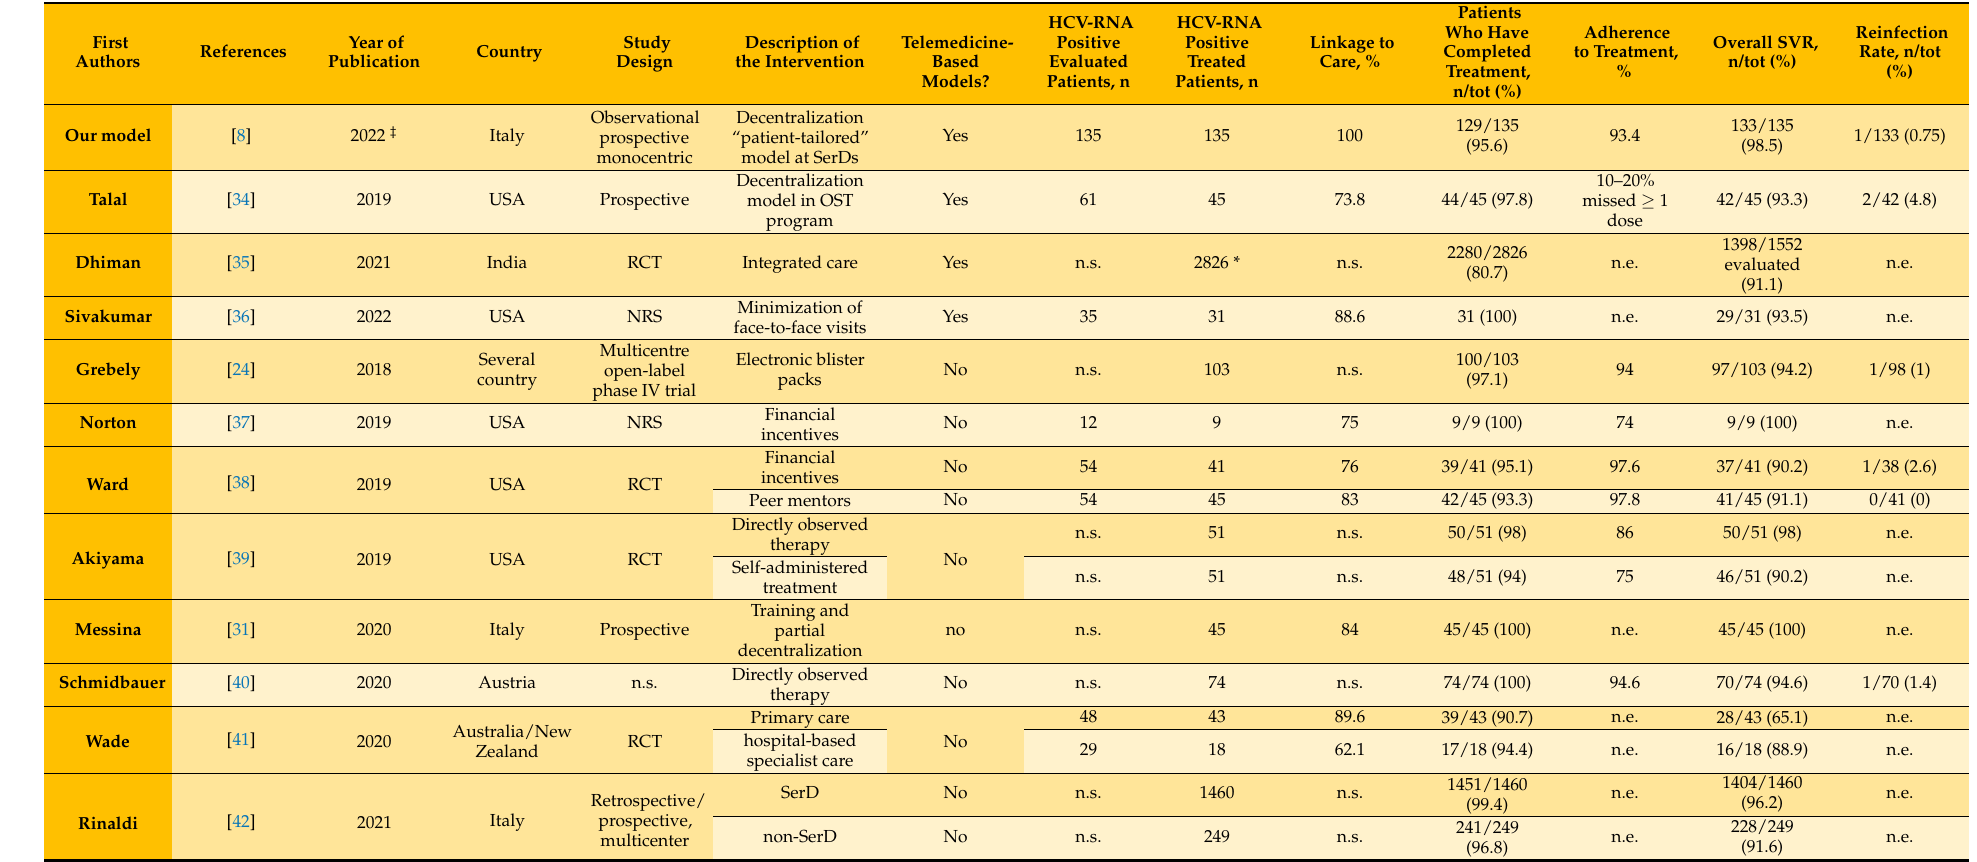
Table 1. Main treatment models of HCV infection in the PWUDs